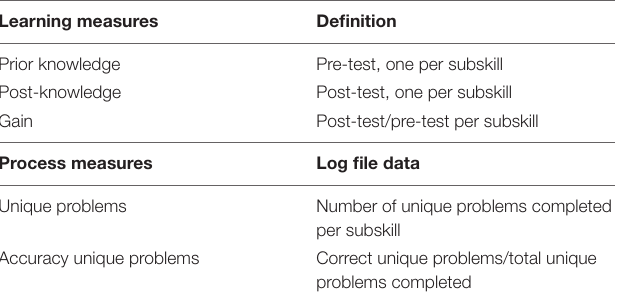
TABLE 2 | Overview of learning, effort, and accuracy